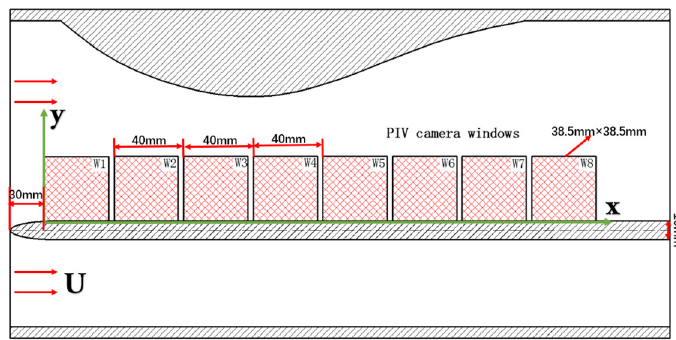
Figure 1. Water tunnel and experimental layout.